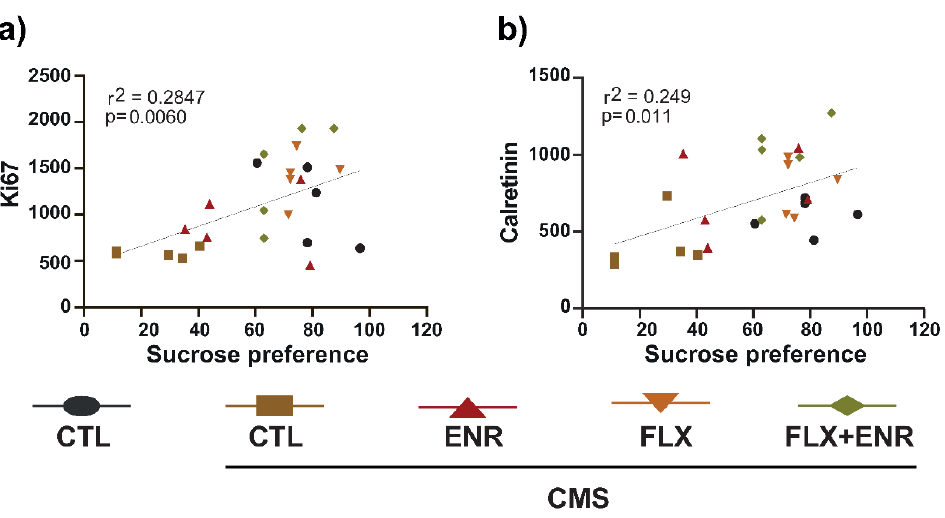
Figure 6. Correlations. ( a ) Scatter graph of Ki67 or ( b ) calretinin with sucrose preference test indicates significant correlation in CTL = unstressed mice, CTL-CMS = stressed mice, ENR = environmental enrichment, FLX = fluoxetine, FLX + ENR = fluoxetine plus environmental enrichment ( n = 5).